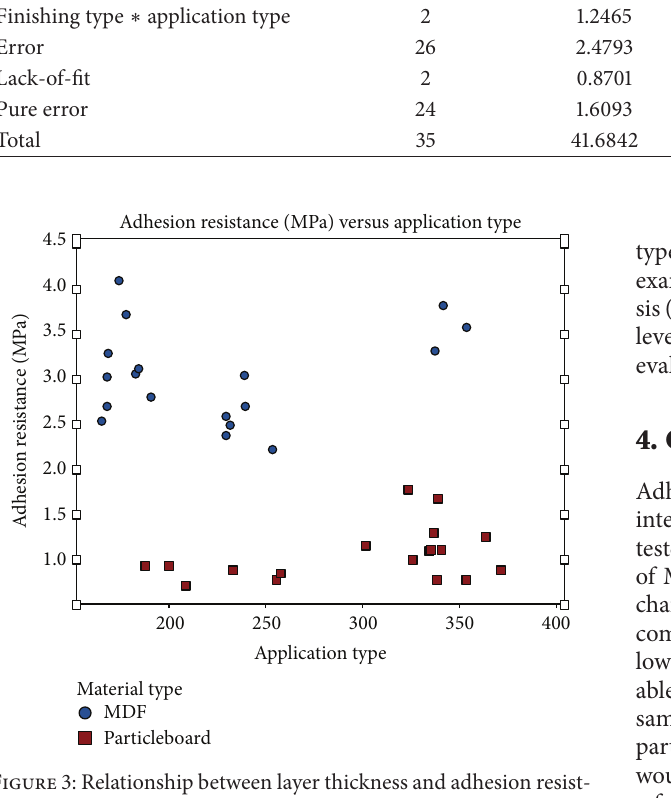
Figure 3: Relationship between layer thickness and adhesion resist- ance of two types of panels.